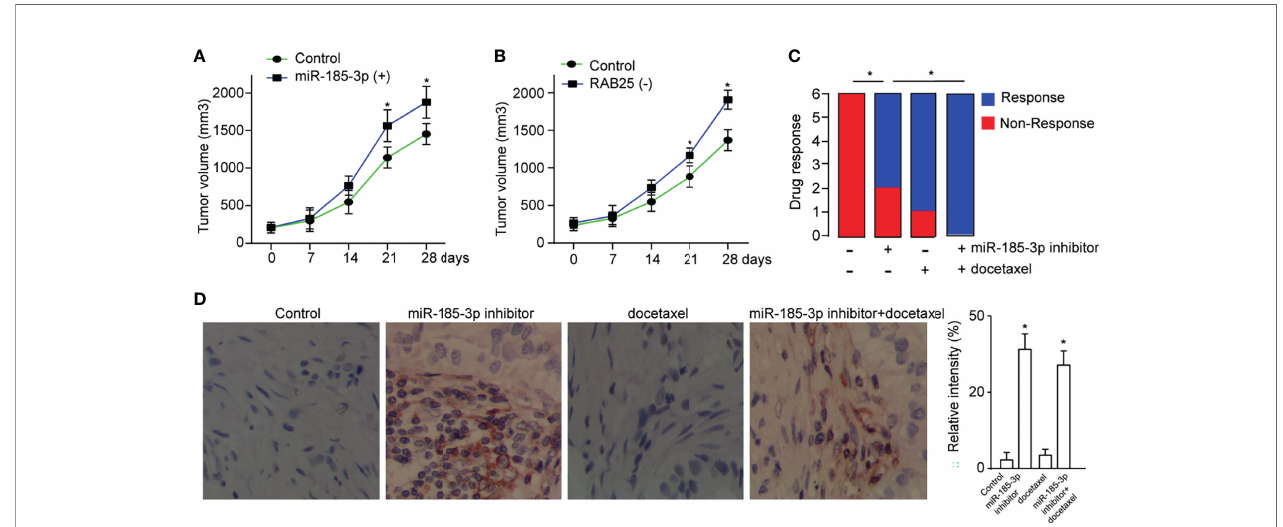
FIGURE 6 | Targeting miR-185-3p/RAB25 therapeutically inhibits cancer progression. (A, B) Tumor volume of mice injected with HN4 with miR-185-3p overexpression or RAB25 knockdown (n=6). (C) The drug response was monitored by evaluating the change of tumor size in tumor-bearing mice after administration with miR-185-3p inhibitor, docetaxel, or combination therapy (n=6). (D) Quanti fi cation and IHC images show the RAB25 expression in tumor tissue of different mice in (C) , * p <